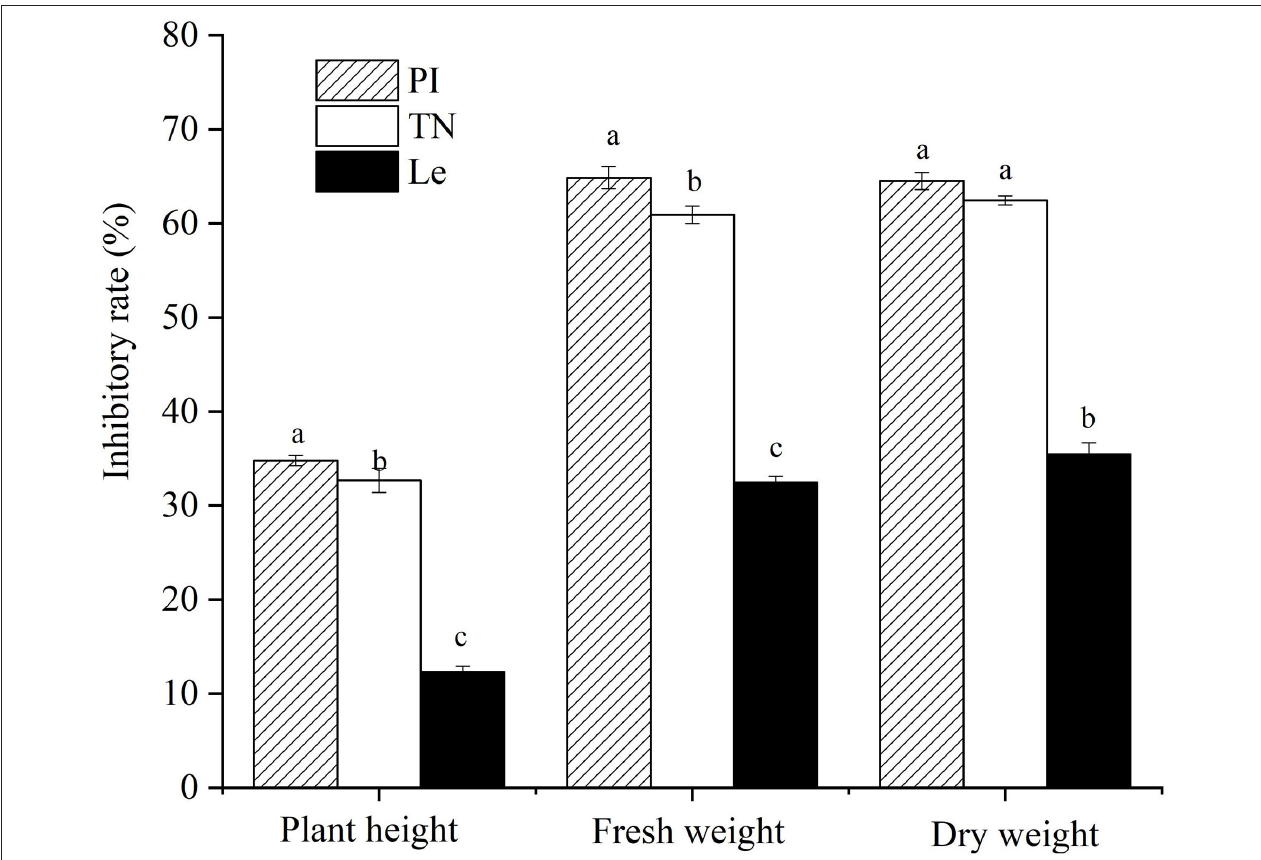
FIGURE 3 | Effects of three rice cultivars on barnyardgrass in situ . PI: allelopathic rice PI312777, TN: allelopathic rice Taichung Native1, and Le: non-allelopathic rice Lemont. Error bars indicate standard deviation. Significant differences ( p < 0.05) between rice cultivars were indicated by different lowercase letters, according to Tukey’s honestly significant difference